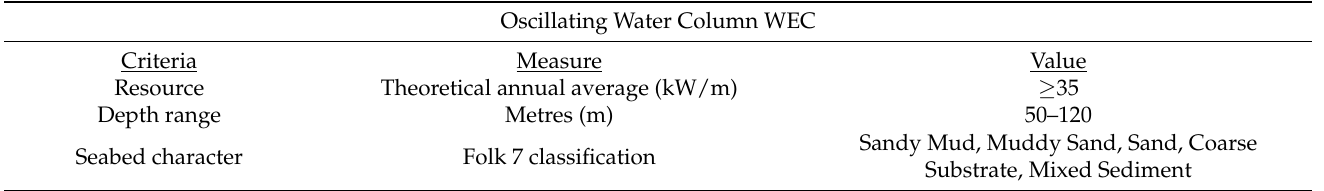
Table 7. Details of wave site selection inputs based on technology developer survey